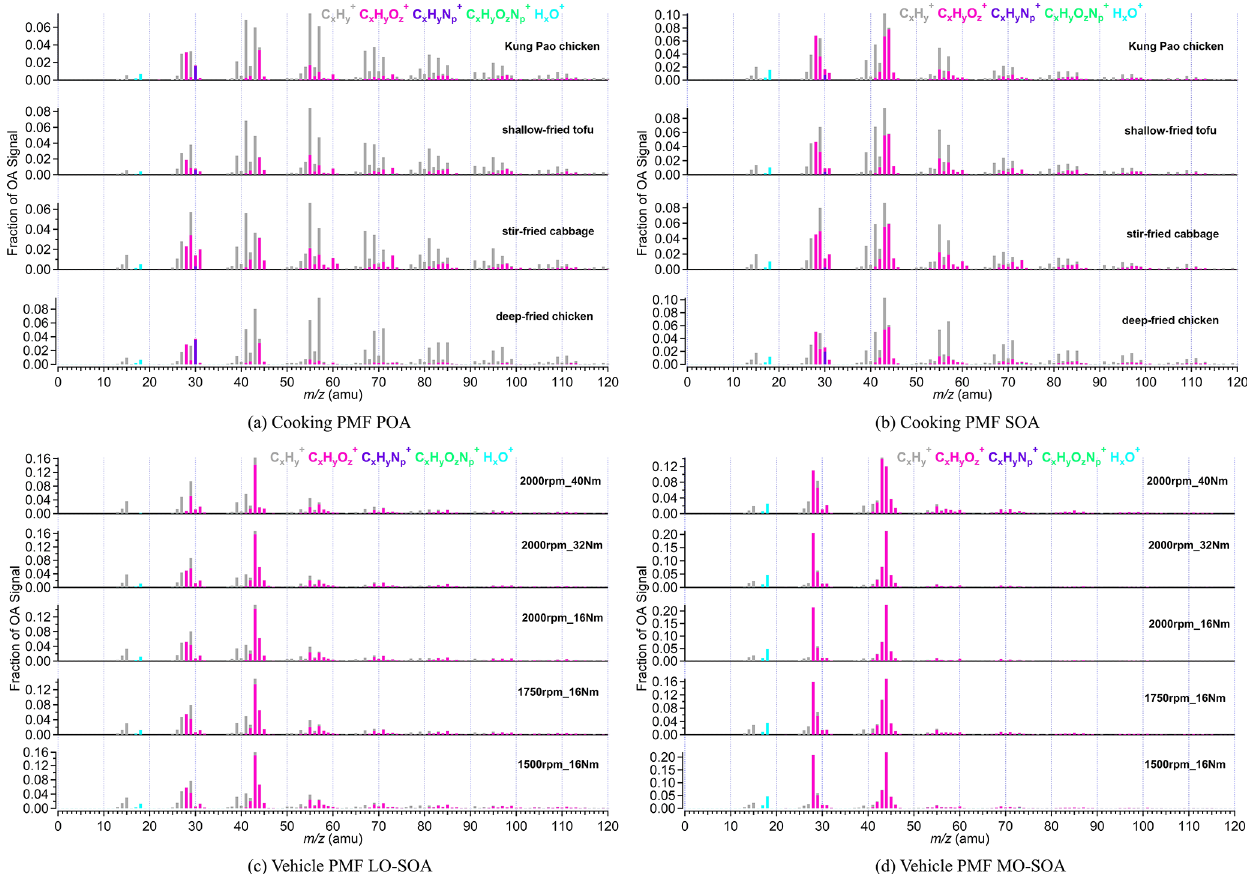
Figure 3. The mass spectra of PMF POA and SOA from vehicle and cooking. PMF analysis was performed on the high-resolution mass spectra to split two factors (cooking POA and SOA) from aged COA and two SOA factors (vehicle LO-SOA and MO-SOA) from aged HOA,